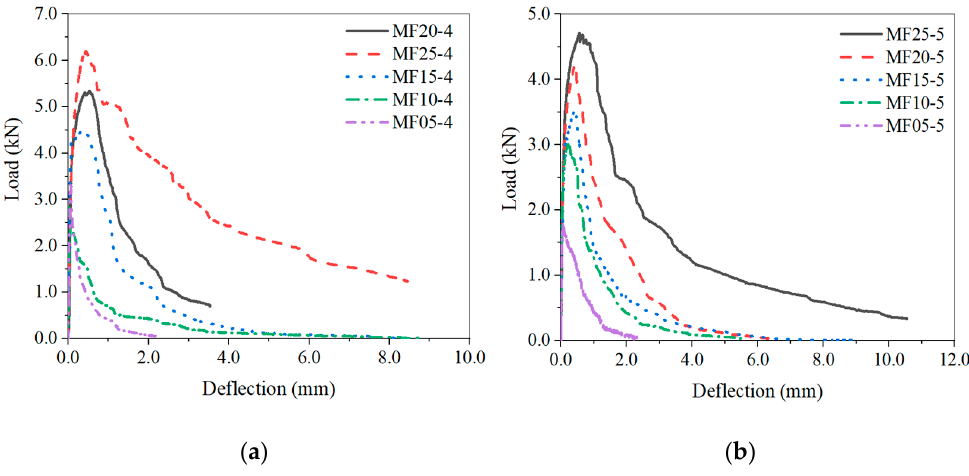
Figure 8. Typical load deflection curves of the SFHSC beams with a 0 /h = 0.4 ( a ) and a 0 /h = 0.5 ( b ).